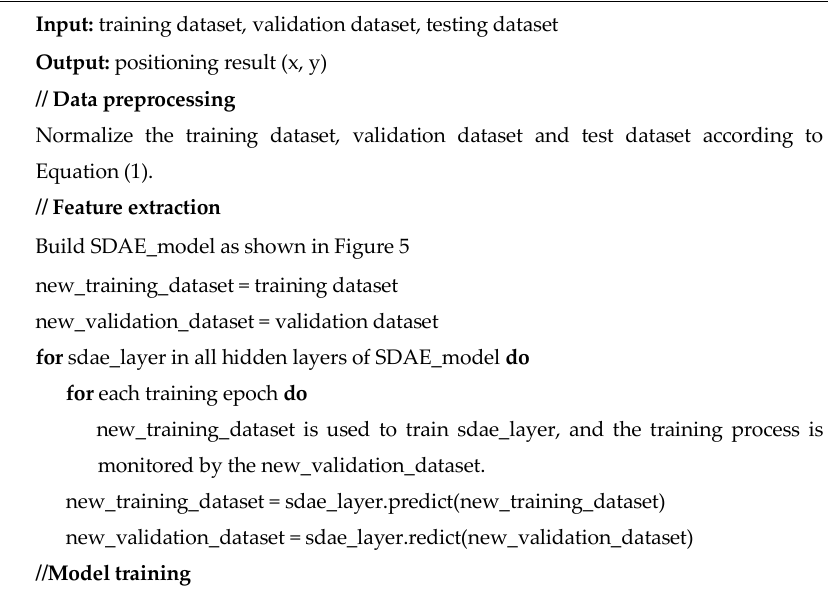
Algorithm 1. robust Wi-Fi fingerprint positioning algorithm using SDAE and MLP